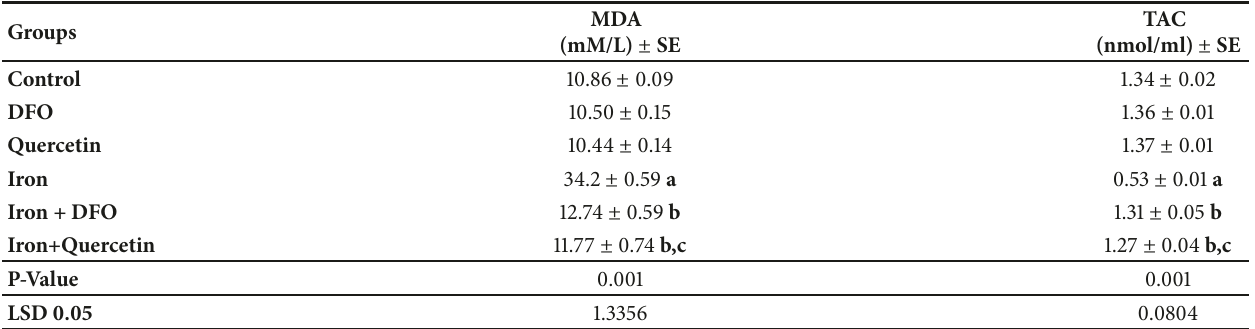
Table 3: Effects of Quercetin in comparison to DFO on serum oxidative stress and total antioxidant capacity in iron overloaded rats. Groups